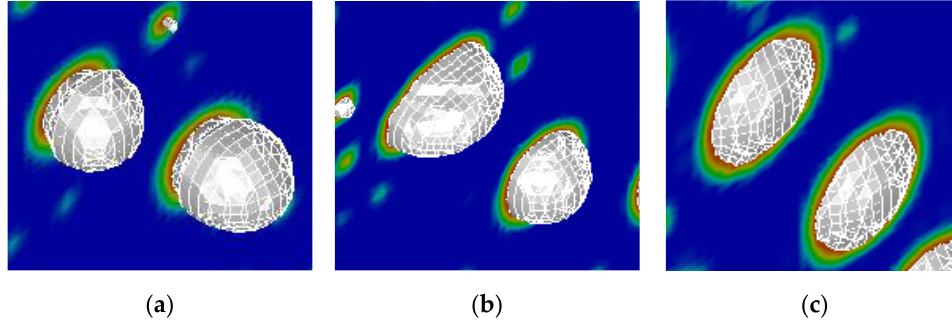
Figure 9. Droplet shapes at different contact angles: ( a ) θ = 45°; ( b ) θ = 90°; ( c ) θ = 135°.